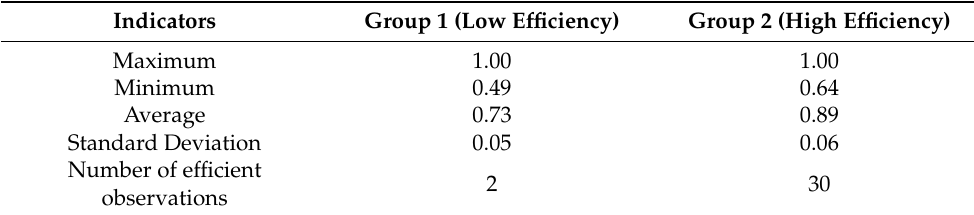
Table 5. Summary of efficiency measures in different groups.